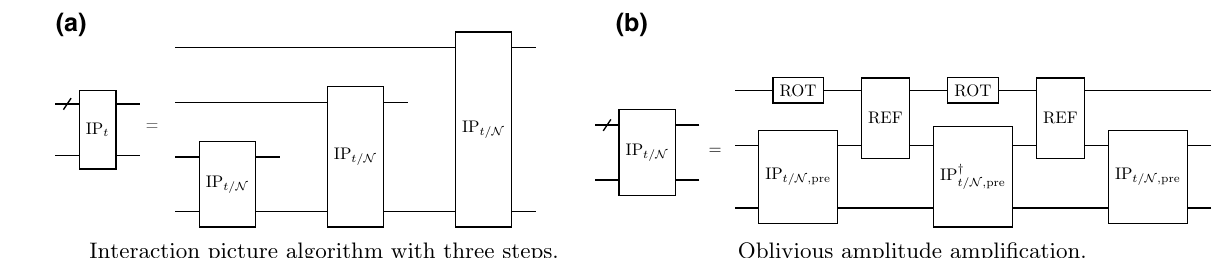
Interaction picture algorithm with three steps. Oblivious amplitude amplification. FIG. 7. Quantum circuits for the interaction-picture algorithm for simulating generic Hamiltonians. + 2] controlled-e isA , 6 N K PREP using 3[ N ( K + 1 ) n t 3 N K SEL , and a number of Toffoli gates B